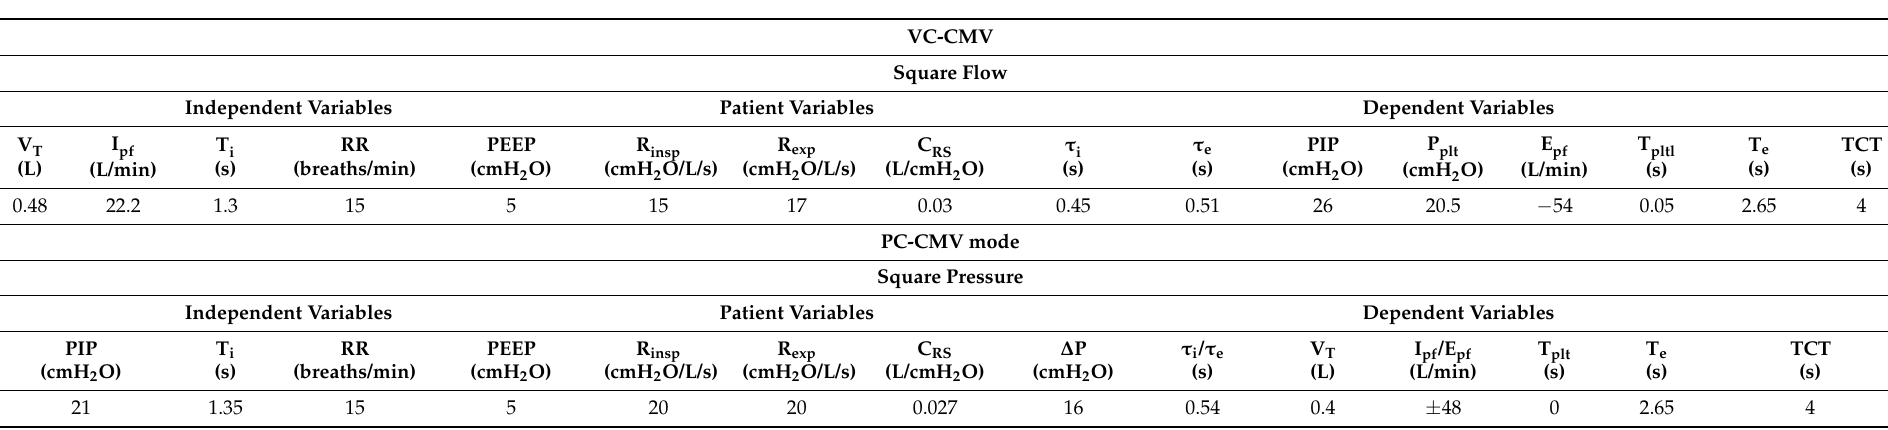
Table 6. Independent, dependent and patient variables of the real-life trends of the Case